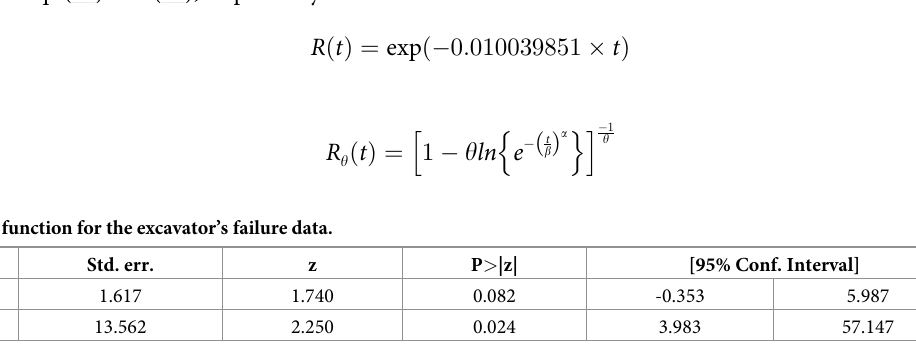
The reliability analysis of the excavator in the classic-exponential and the Weibull-frailty models is shown as Eqs (33) and (34), respectively.